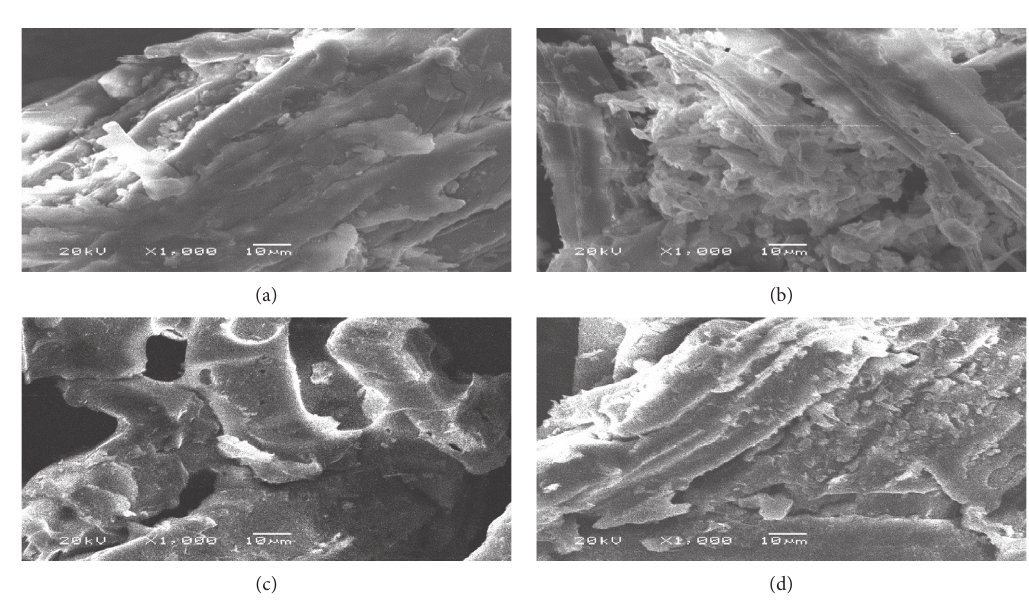
Figure 3: SEM photograph for surface of (a) NPS. (b) SPS before and after adsorption of